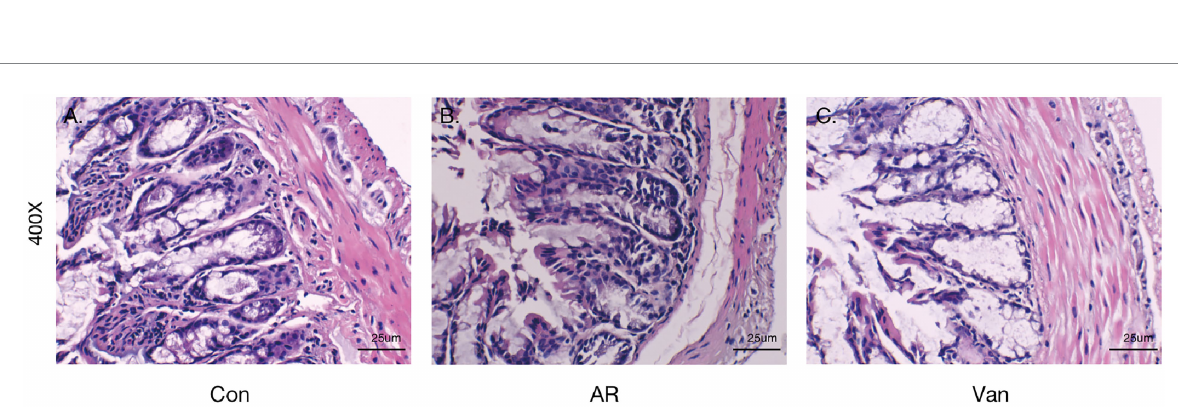
FIGURE 10 Vancomycin-induced gut microbiota dysbiosis aggravates intestinal barrier inflammation and injury. H&E staining of colonic mucosa (400×). (A) the Control group; (B) the AR group; (C) the Van